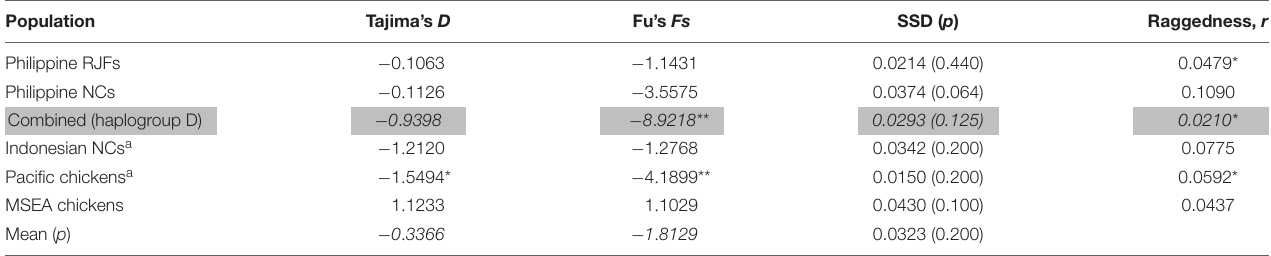
TABLE 4 | Neutrality tests and mismatch analysis sums of squared deviation (SSD) and Harpending’s raggedness index for Philippine RJF and NC complete mtDNA D-loop